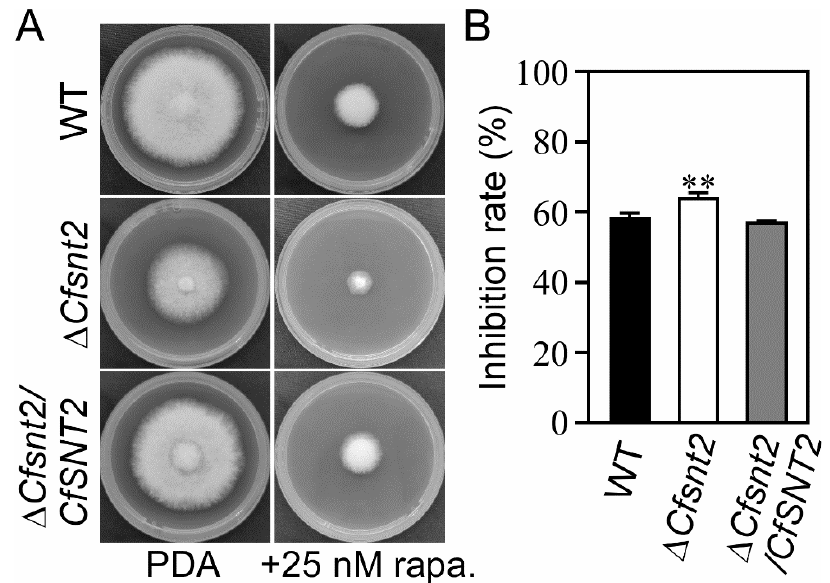
Figure 6. CfSnt2 is involved in the rapamycin response. ( A ) T he strains of WT, Δ Cfsnt2 mutant, and compleme nted strain Δ Cfsnt2/CfSNT2 were incubated in PDA media or PDA media with 25 nM rapamycin at 28 °C for 3 days. ( B ) Statistical analysis of inhibited rates of the strains to rapamycin stress. Three independent experiments were performed, with three biological replicates each time. Error bars indicate SD of three replicates (** p < 0.01).